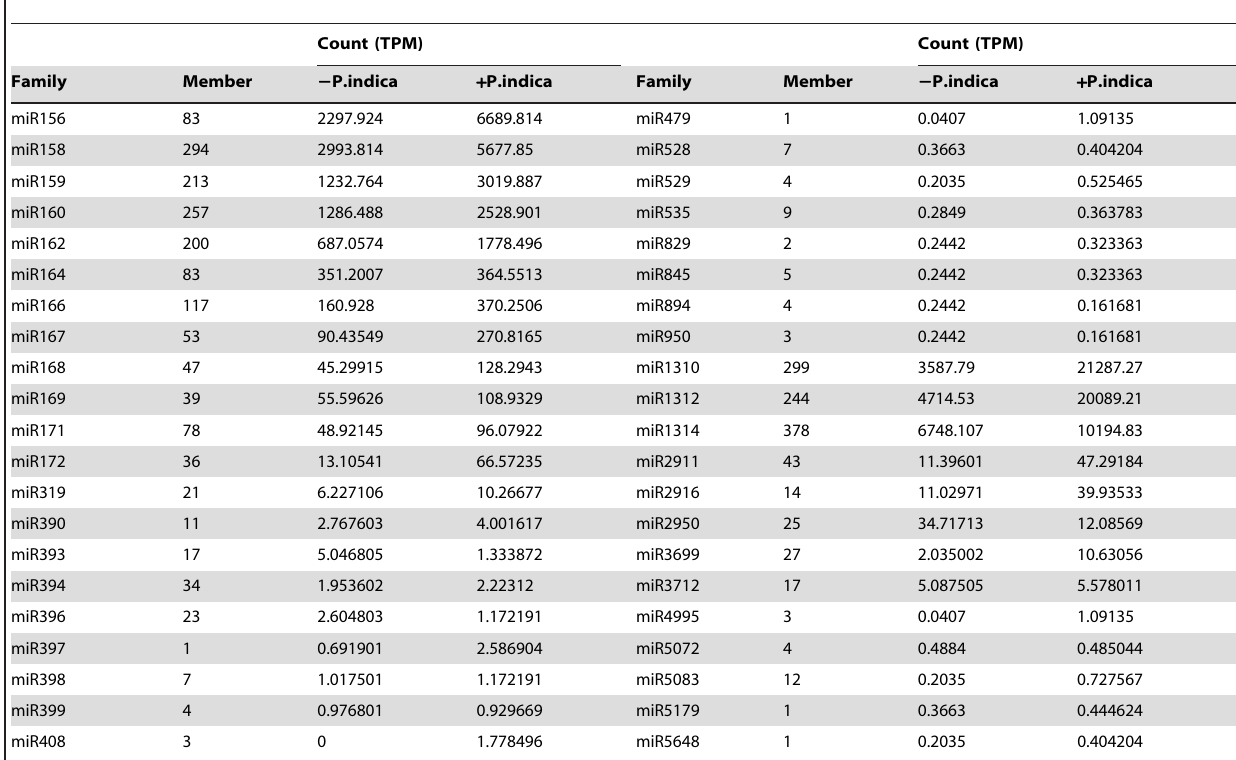
Table 2. Family members and counts of conserved miRNAs detected in root tissues of Oncidium orchid 6 P. indica